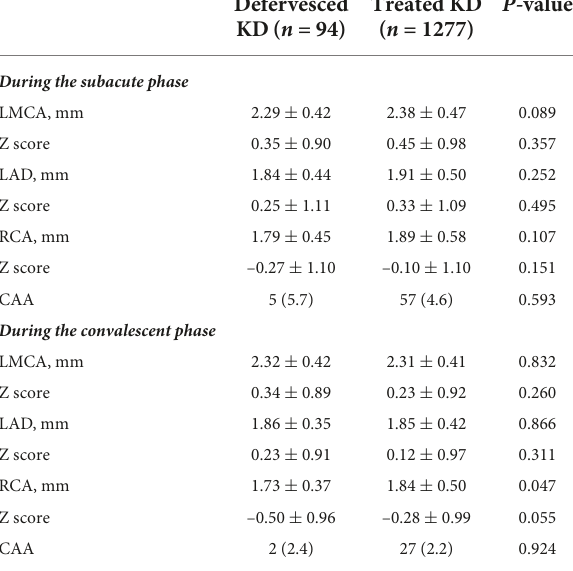
TABLE 2 Coronary artery status during subacute phase and convalescent